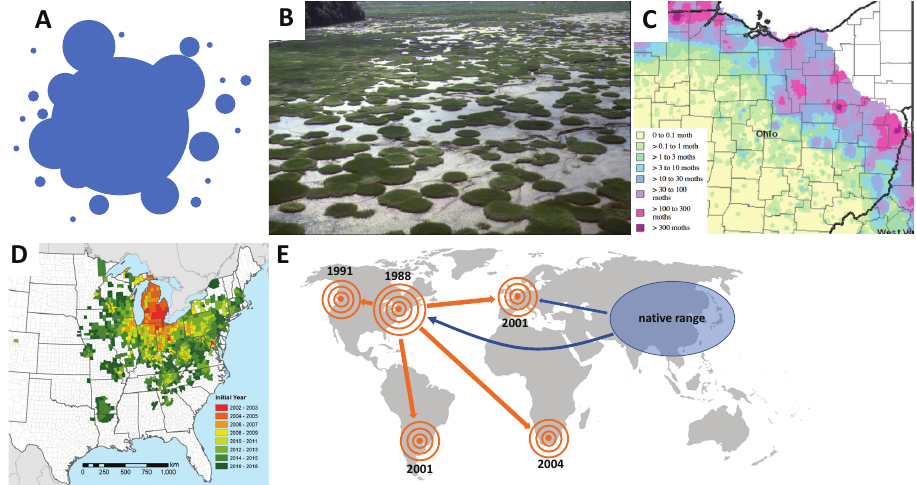
Figure 1. Examples of coalescing colonies seen in the invasions of different species viewed at varying scales A conceptual representation of invasion via coalescing colonies B aerial photo showing Spartina al- terniflora invasion into Willapa Bay, WA, (photo by Fritzi Grevstad) C spread of the gypsy moth, Lyman- tria dispar , in Ohio, USA. Interpolated pheromone trap captures from 2019 (data at http://yt.ento.vt.edu/ da/) D spread of the emerald ash borer, Agrilus planipennis , in the eastern USA showing year of first discov- ery by county (data from USDA APHIS) e historical global spread of the Harlequin ladybird Harmonia axyridis (modified from Lombaert et al. 2010). Eastern North America has functioned as a bridgehead region from which colonization of other continents has